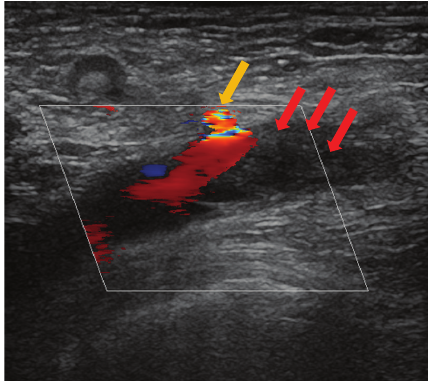
Figure 1: Thrombotic occlusion of the left common femoral artery (CFA). Absence of flow can be appreciated in the distal part of the vessel, associated with thrombus formation (red arrows). The origin of a collateral artery can be depicted proximally to the vessel occlusion (yellow arrow).